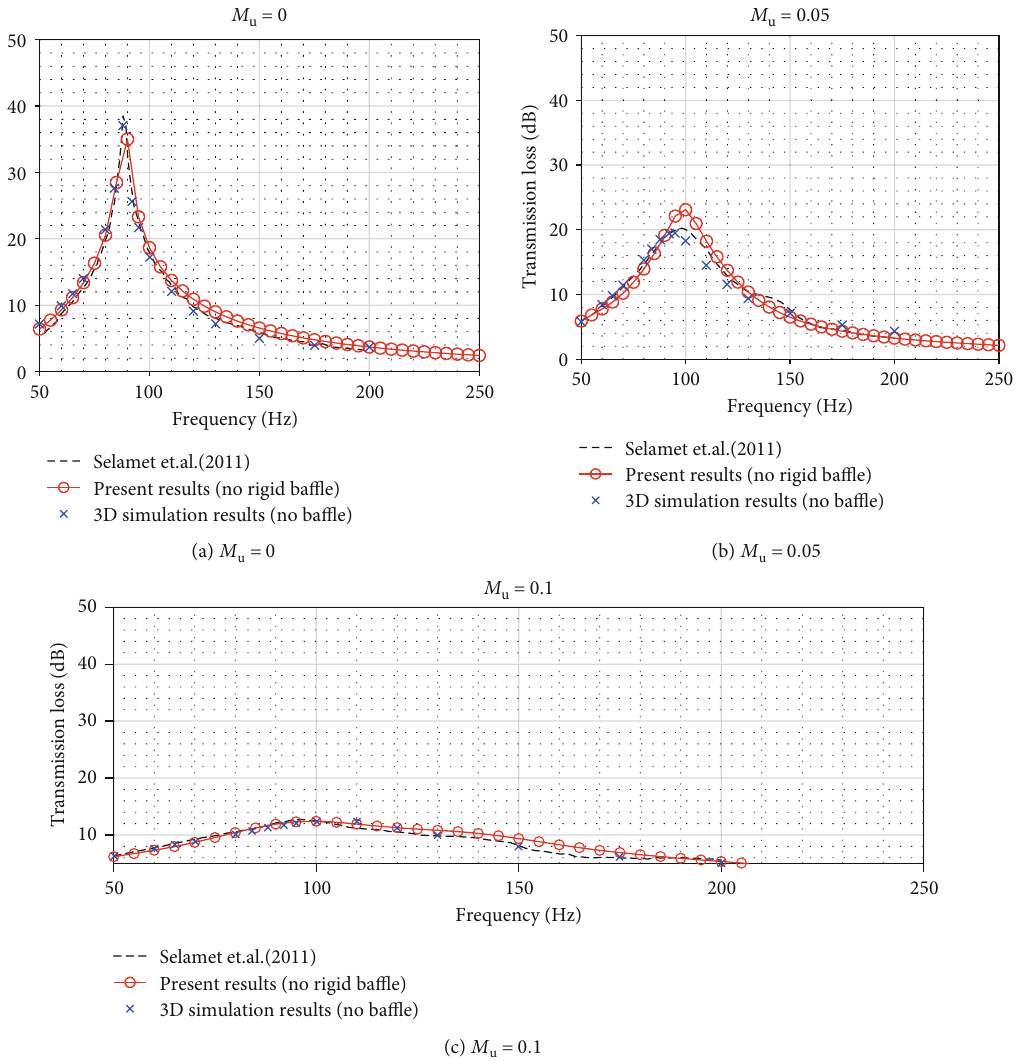
Figure 3: Comparing the current predicted transmission losses with those obtained from the present mode, 3D results [1] and the experimental ones Ref.